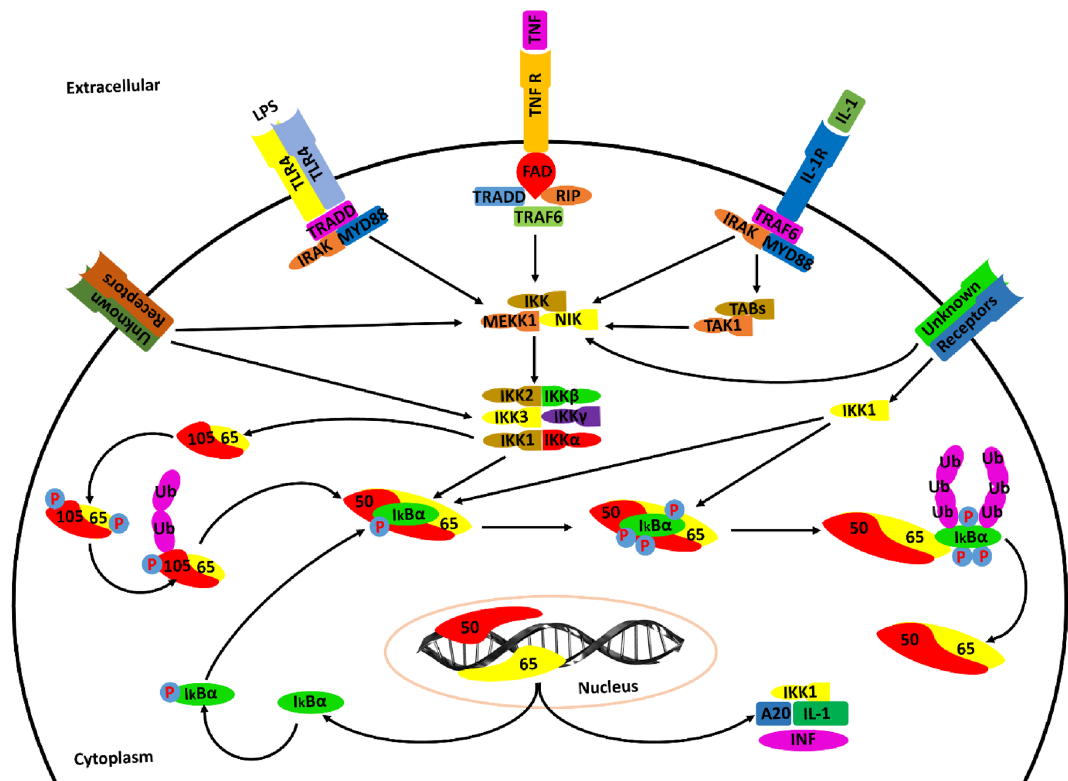
Figure 12. NFkB is the major cascade cross talked by TNF signaling. TNF mechanistic signaling occurs primarily via its TNFR1 and TNFR2 receptors ubiquitously expressed in brain tissues in AD patients. The extracellular domain of TNF receptors is immediately characterized by the presence of cysteine-rich CCG domains that mediate the specific ligand receptor interaction. Other transcription factors such as p38 and c-Jun terminal kinase (JNK) is also activated through downstream regulation of TRAF2 and RIPK1. TRADD uses its death domains to bind to the TNFR1 complex where it is most likely to express as a scaffold to recruit